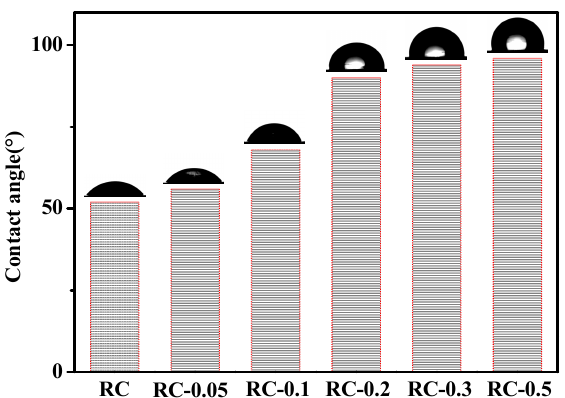
Figure 8. TGA ( a ) and DTG ( b ) curves for RC and RC/CeO 2 nanocomposite films under nitrogen atmosphere; ( c ) the influences of Ce(NO 3 ) 3 ·6H 2 O concentrations on the content of the incorporated CeO 2 NPs (wt%) in the nanocomposite films; ( d ) the temperature at 5 wt% decomposition of RC and RC/CeO 2 nanocomposite films.